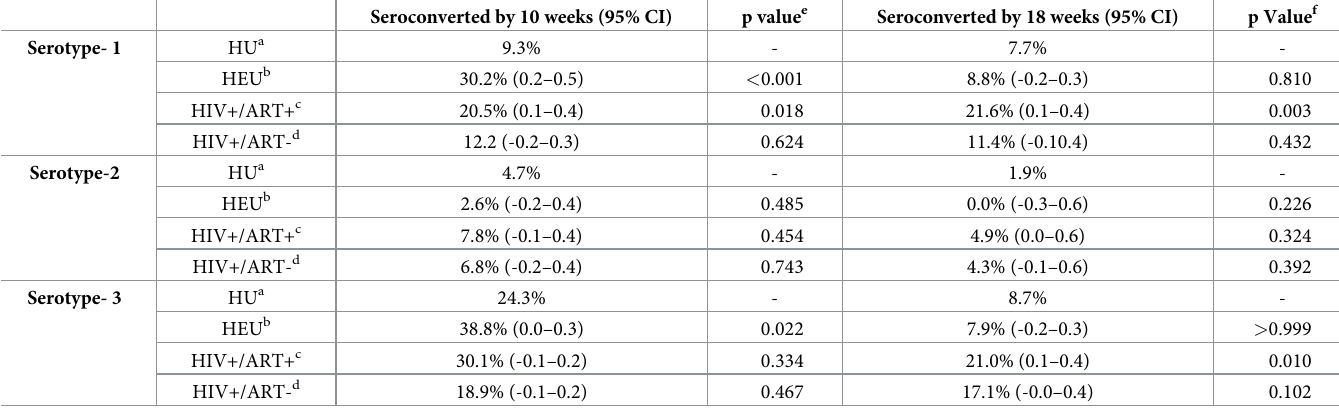
Table 3. Seroconversion rates by 10 and 18 weeks of age.